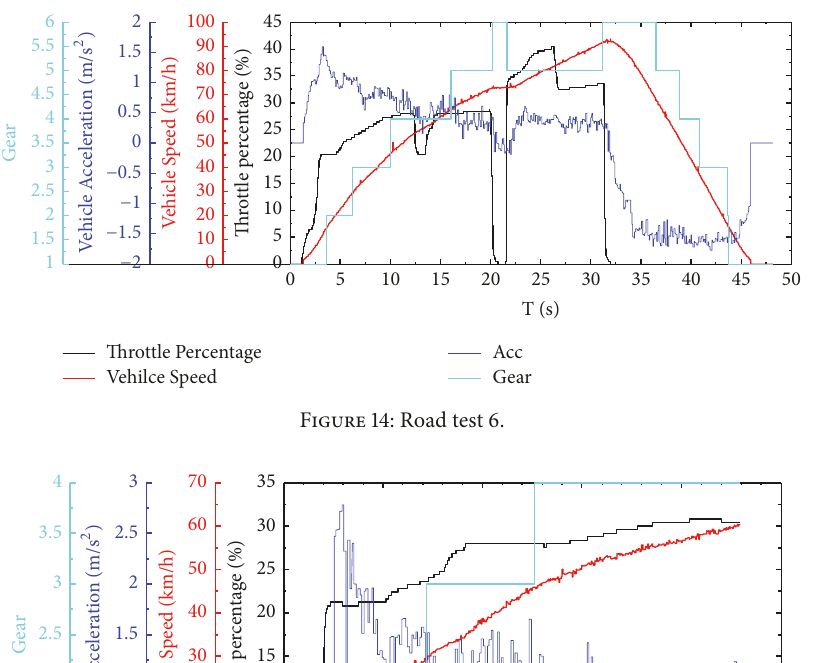
Figure 13: Road test 5.